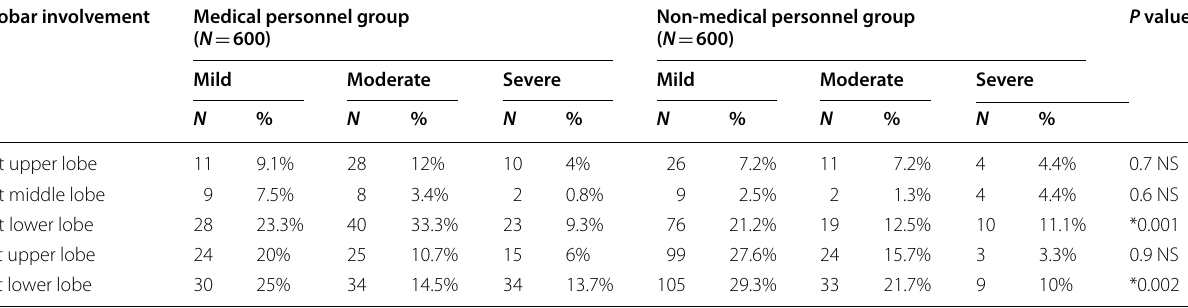
Table 6 Comparison between medical personnel and non-medical personnel groups, as regards distribution of lobar lung involvement ( N =